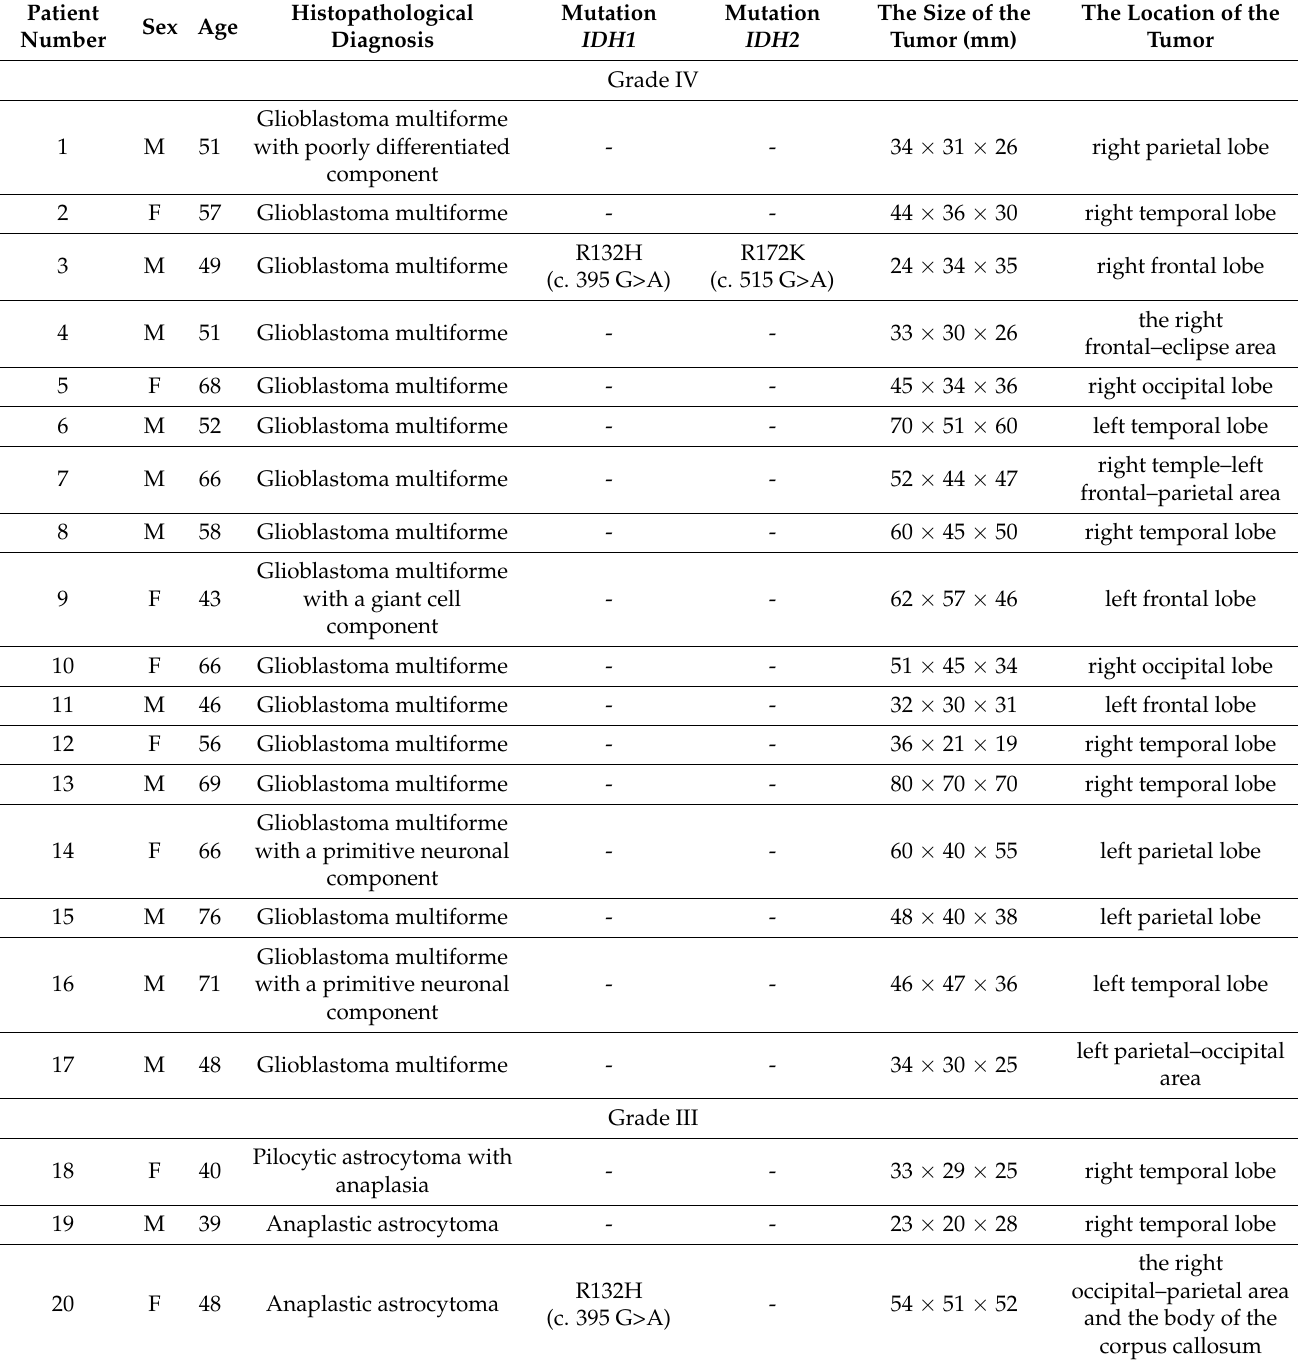
Table 1. Clinical characteristics of